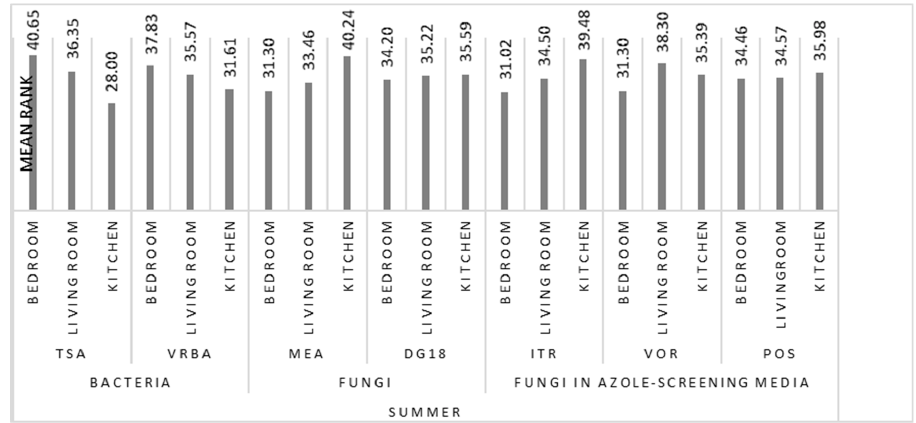
Figure 4. Results of the Kruskal–Wallis multiple comparisons of bacterial and fungal counts,